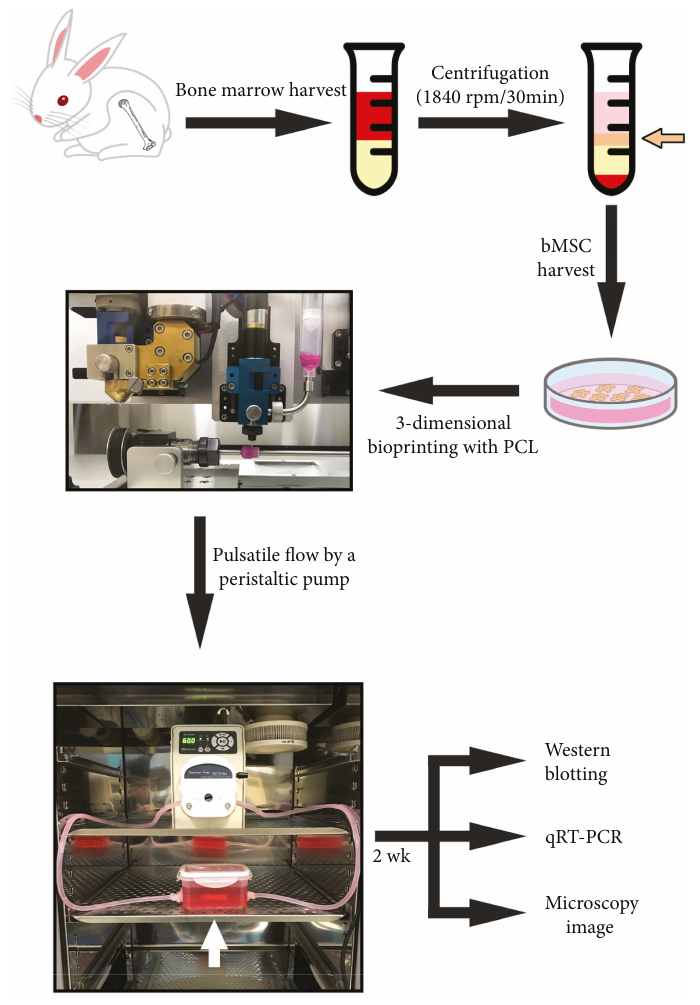
Figure 1: Scheme diagram of the experimental